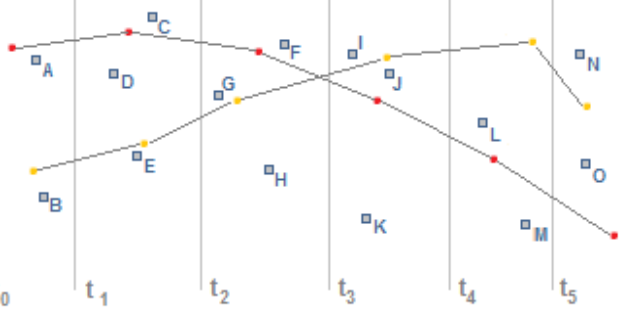
Figure 3. The data assignment task: The initial setting contains two continuous GPS trajectories (connected red and yellow dots) and unassigned camera detections (isolated blue boxes), both in the common local coordinate system. The time progression is indicated